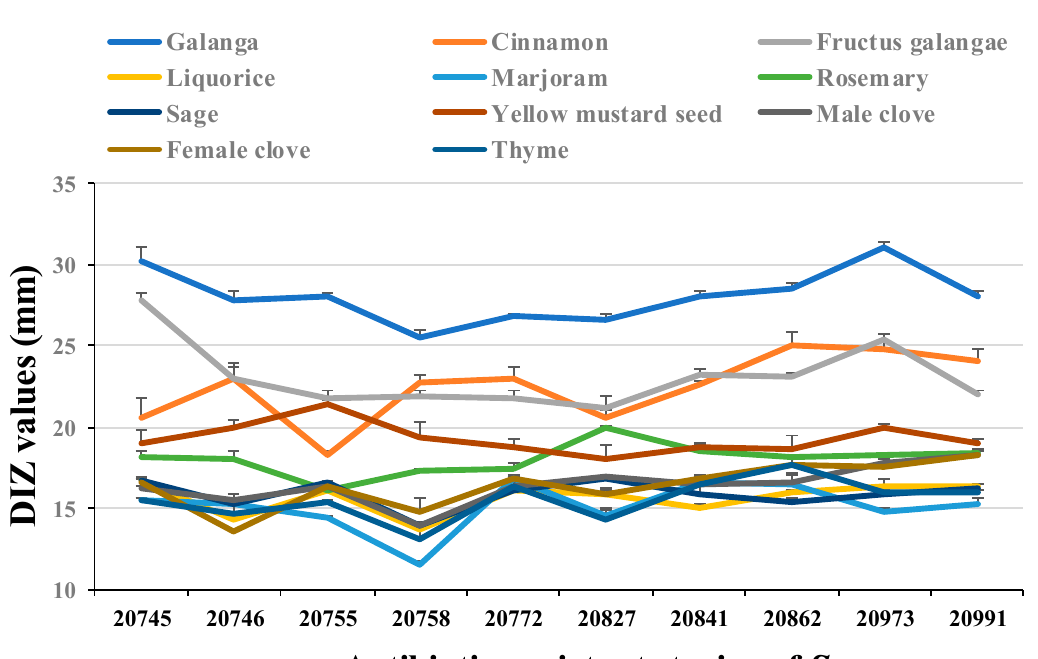
Figure 1. The antibacterial activity of selected spice extracts on 10 antibiotic-resistant strains of S. aureus .